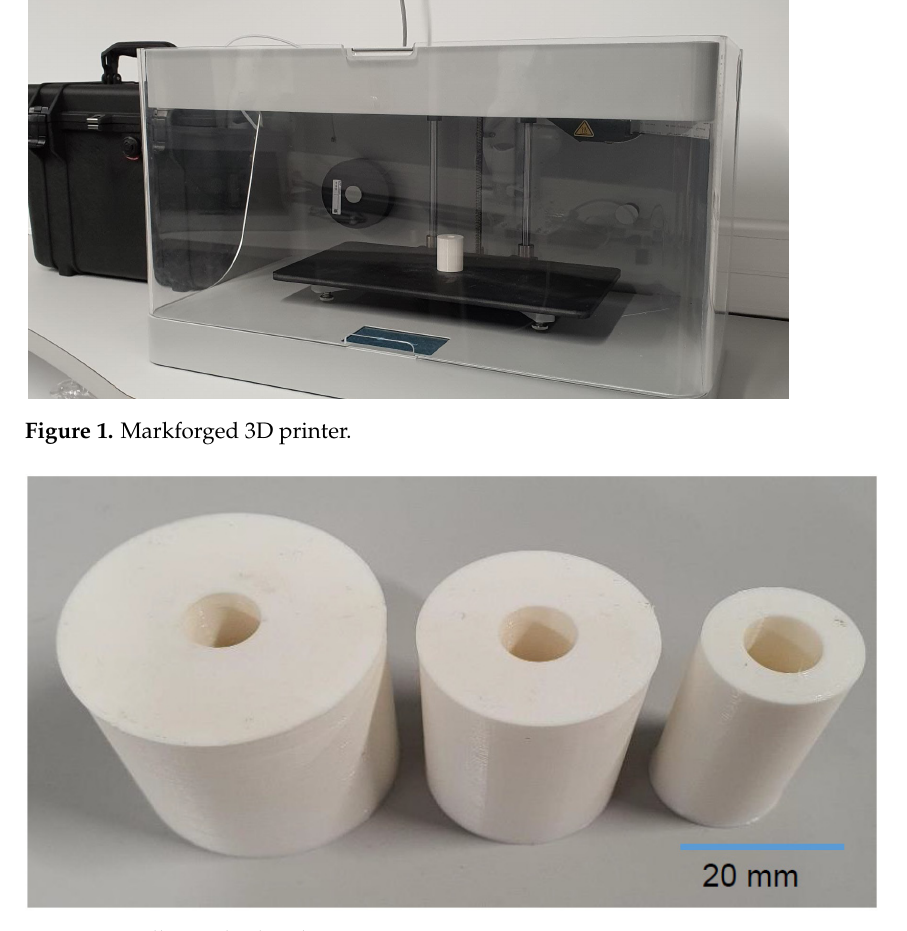
Figure 2. Hollow cylindrical parts. Table 1. The process parameters and their levels.